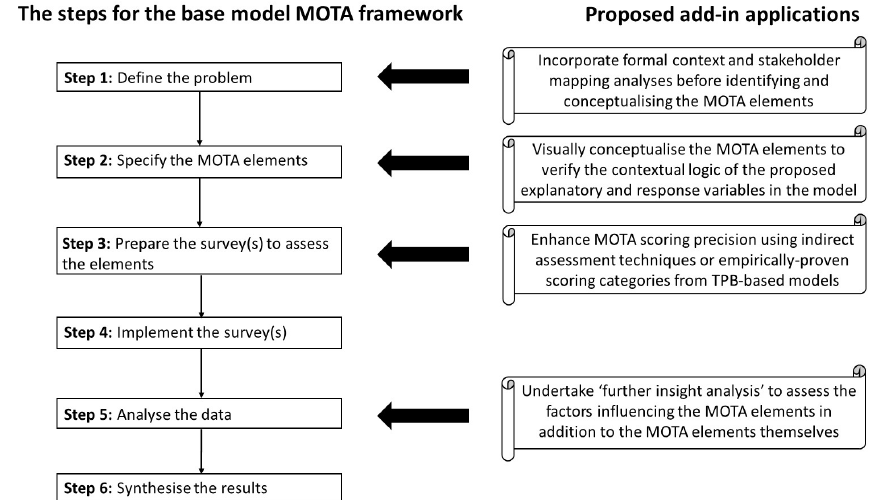
Figure 3. An overview of the steps for the base model MOTA framework and our proposed add-ins to the framework for assessing the implementation feasibility and/or social adoptability of water resources management plans and policies. TPB represents theory of planned